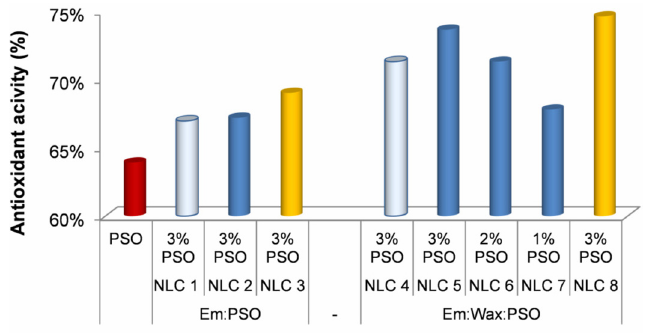
Figure 7. The antioxidant properties of the lipid nanocarriers synthesized with various solid lipids and oil concentrations.